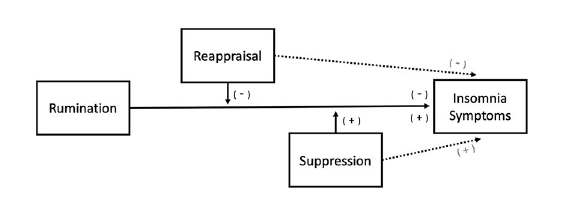
FIGURE1 Proposed moderation model. Negative Rumination and Dampening are predicted to increase subjective sleep difficulty whereas two predictions (either increase or decrease) for Positive Rumination are possible. Reappraisal is predicted to attenuate the effects of rumination whereas Suppression is expected to enhance the effects. Additionally, Reappraisal is independently expected to reduce subjective sleep difficulty, and Suppression to